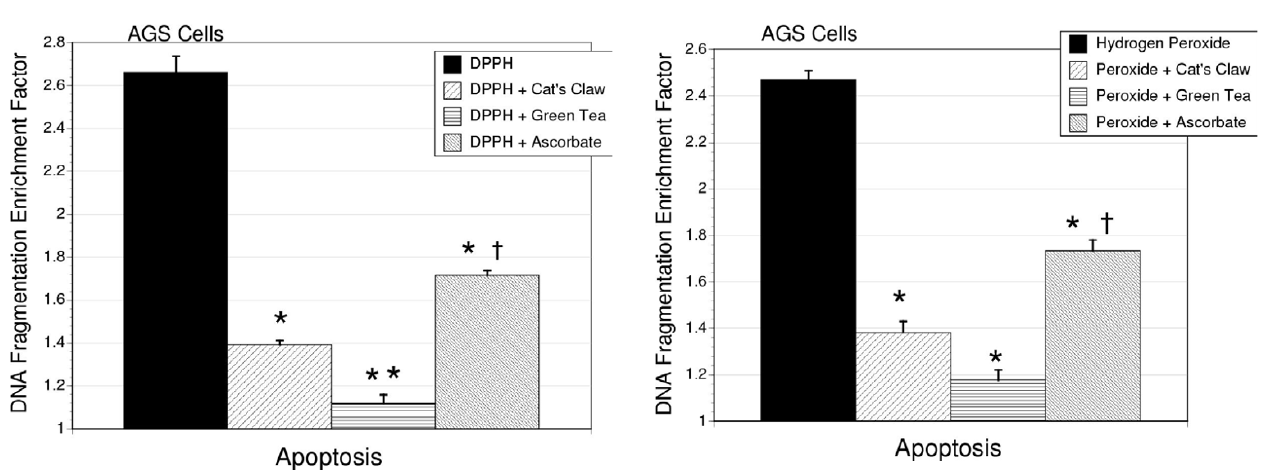
Figure 3 Apoptosis, measured as by histone-associated cytosolic DNA fragmentation, in AGS cells treated with DPPH alone (3 µ M) or in combination with cat's claw, green tea extract or ascor- bic acid (10 µ g/ml). The * designates a significant difference from DPPH alone (P < 0.01), ** a significant difference between green tea and cat's claw (P < 0.05) and † significant difference between ascorbic acid and either green tea or cat's claw treated groups (P < 0.1).